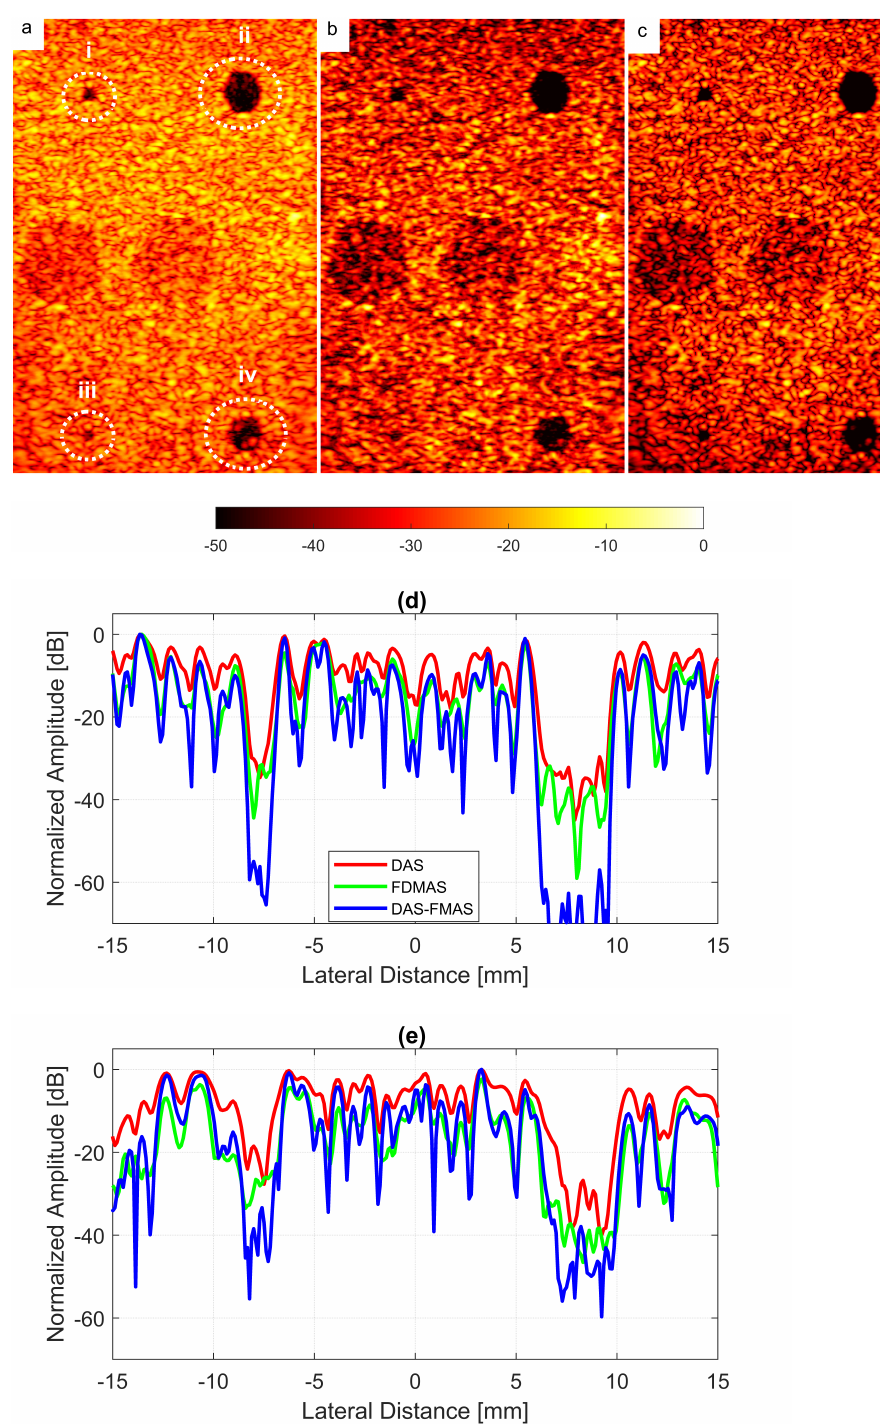
Figure 14. Cyst phantom B-mode images for ( a ) DAS, ( b ) FDMAS and ( c ) DAS-FMAS were produced with N = 13. Beam profiles along the lateral direction at ( d ) 15 mm and ( e ) 45 mm depth. The two smallest circles (ii and iii) and the two largest circles (ii and iv) at 15 mm and 45 mm depth represent 1.3 mm and 3.0 mm diameter cysts,